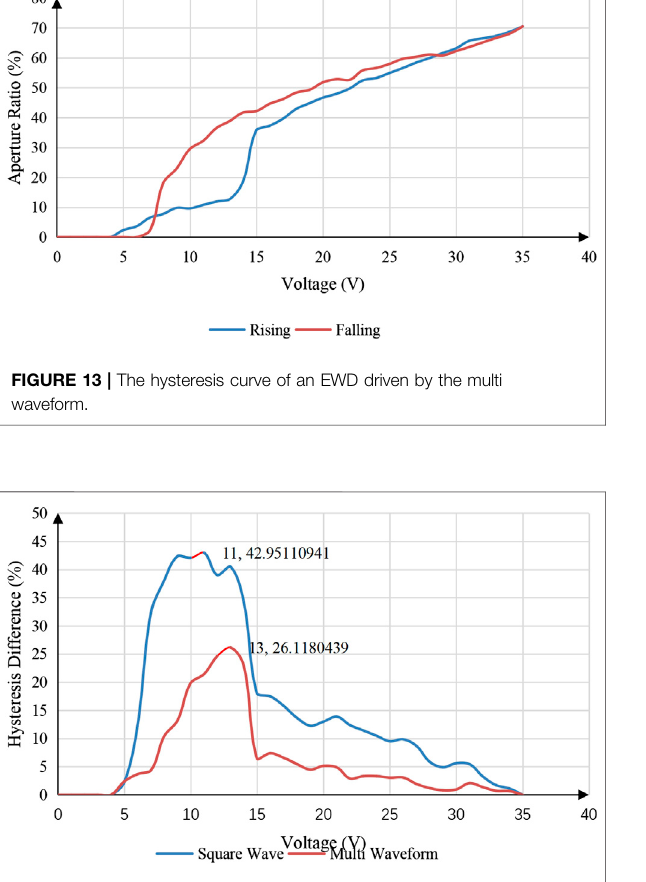
FIGURE14| Comparison ofthehysteresisdifference ofanEWD whenit was driven by a square wave and a multi waveform.